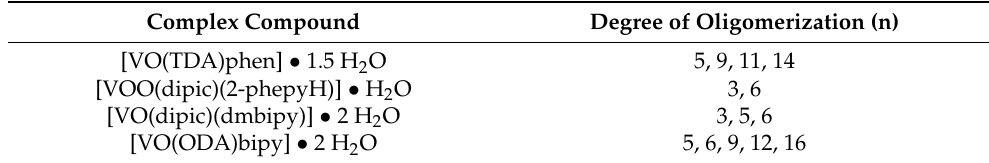
Table 4. Degree of oligomerization for 3-buten-2-ol oligomers obtained using oxovanadium(IV) precatalysts.